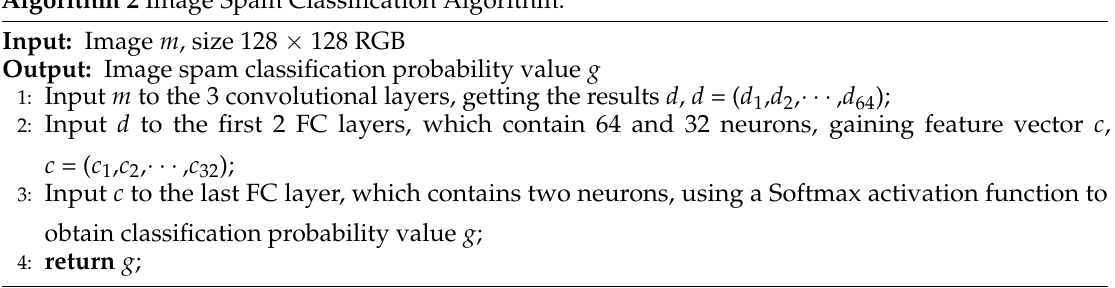
Algorithm 2 Image Spam Classification